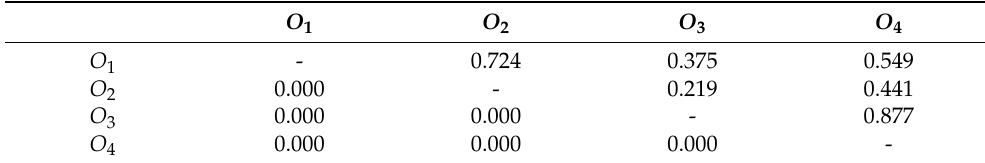
Table 24. The modified discordance matrix.